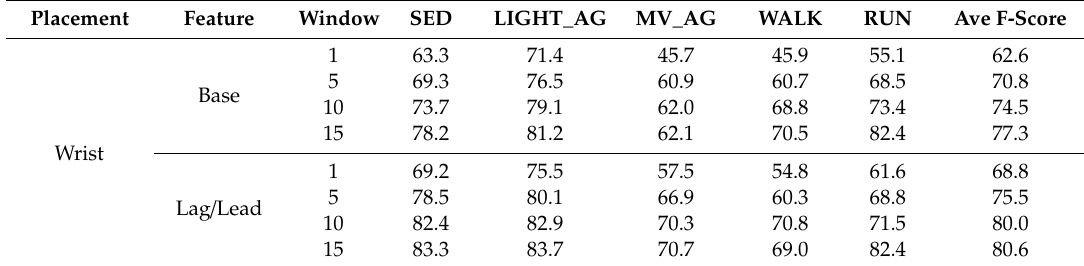
Table 2. F-scores for the five activity classes and the weighted average F-score for each model. Placement Feature